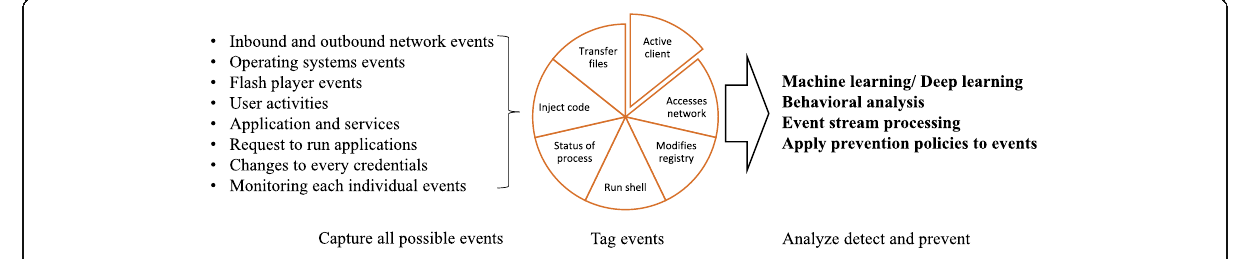
Fig. 4 A framework to detect and prevent fileless malware